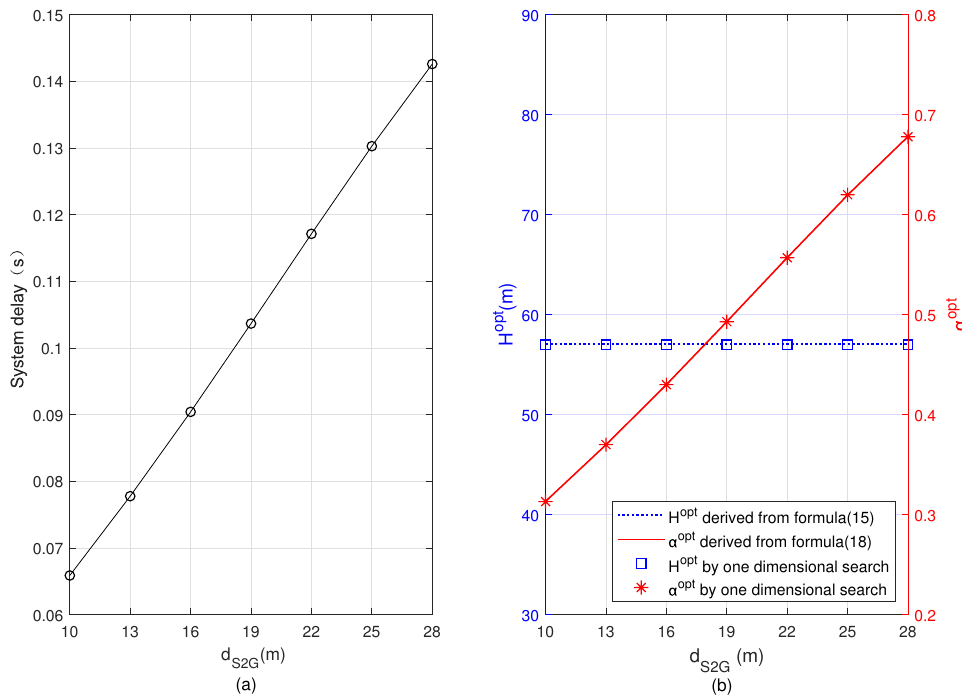
Figure 7. Minimum system delay, optimal flying altitude, and optimal task allocation ratio versus the distance between the user and the BS. ( a ) Minimum system delay, ( b ) optimal flying altitude and optimal task allocation ratio.